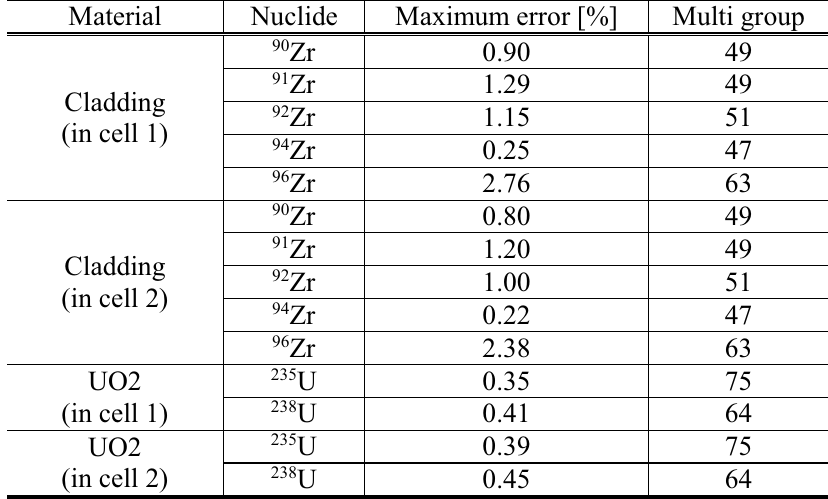
Table IV. The maximum relative errors of effective total cross sections calculated by the